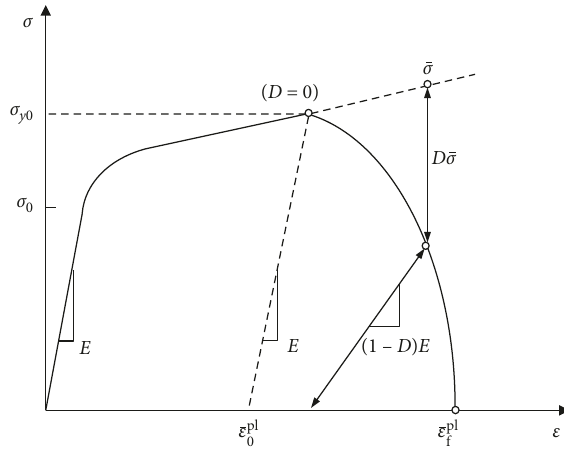
Figure 1: The plastic damage failure